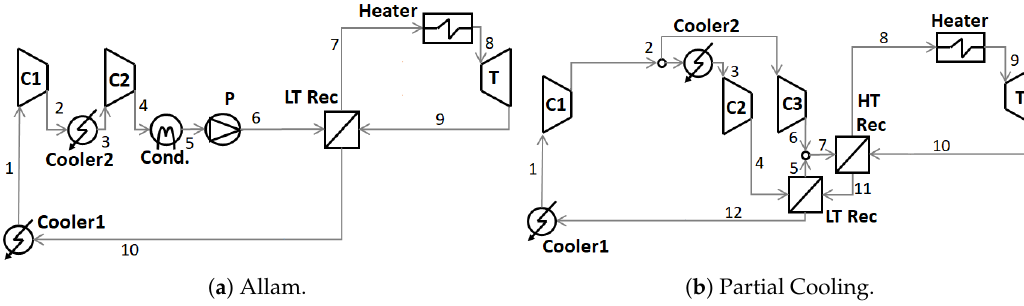
Figure 4. Layouts of the Allam and Partial Cooling